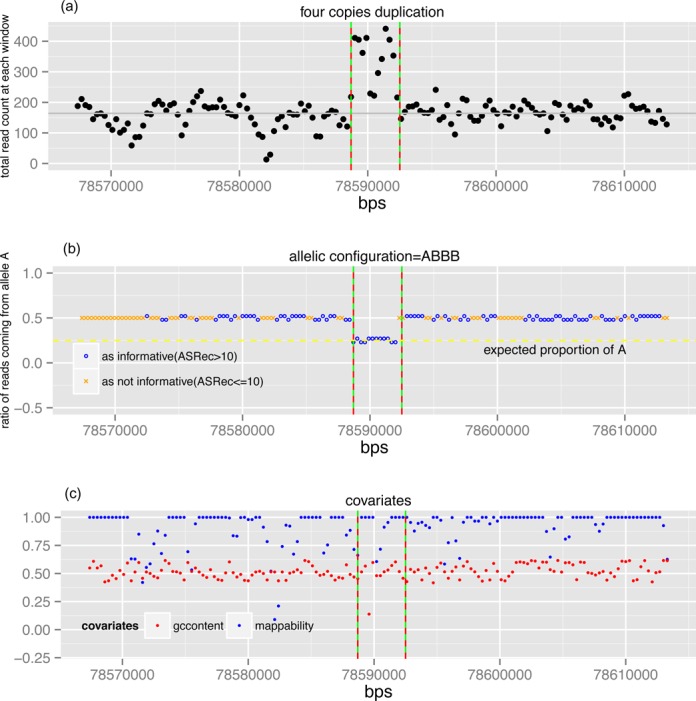
Example of CNV predicted by AS-GENSENG through joint analysis of read-count, allele-specific information and bias correction. In each panel, the X-axis indicates genomic position in chromosome one in base pairs. (a) Black dots on the Y-axis indicate read-count signal; red dashed lines are boundaries from ASGENSENG prediction; green solid lines are ground-truth boundaries; and gray lines are the median read-count of the chromosome. (b) Symbols on the Y-axis indicate the ratio of proportion of reads coming from allele A. A blue circle indicates that the number of allele-specific reads at the corresponding genomic region is >10 (i.e. AS informative); an orange cross indicates that the number of allele-specific reads at the corresponding genomic region is ≤10 (i.e. not AS informative); the yellow dotted line is the expected proportion of allele-specific reads coming from allele A. (c) GC content and mappability of the region. These data predict a duplication with four-copies and an allelic configuration of ABBB. Although the TReCs at some regions are highly affected by mappability and GC content, AS-GENSENG still makes the correct CNV call. This result illustrates the method's favorable sensitivity for detecting duplications from noisy regions, by employing simultaneous bias correction and jointly using both read-count and allele-specific information in the inference.